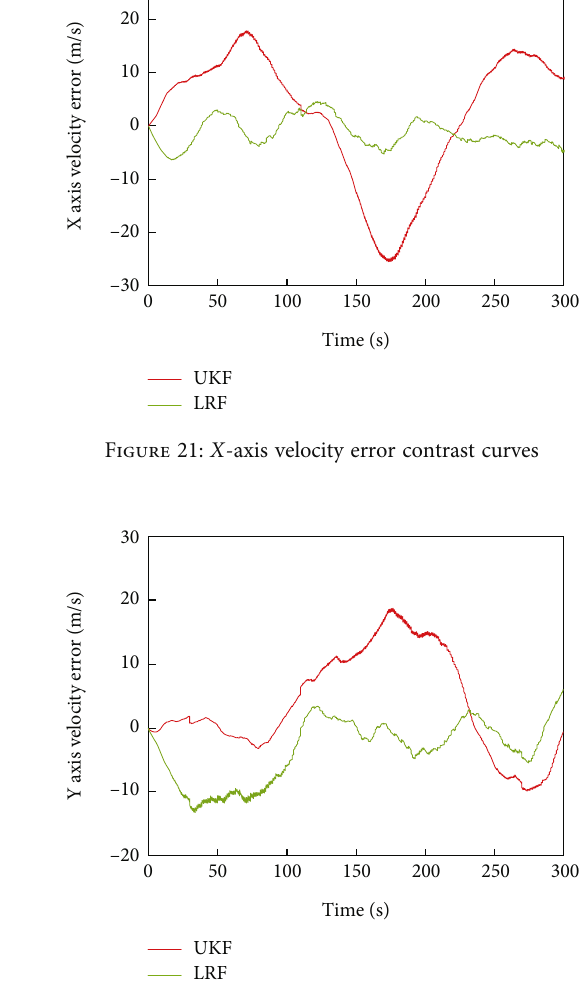
Figure 22: Y -axis velocity error contrast